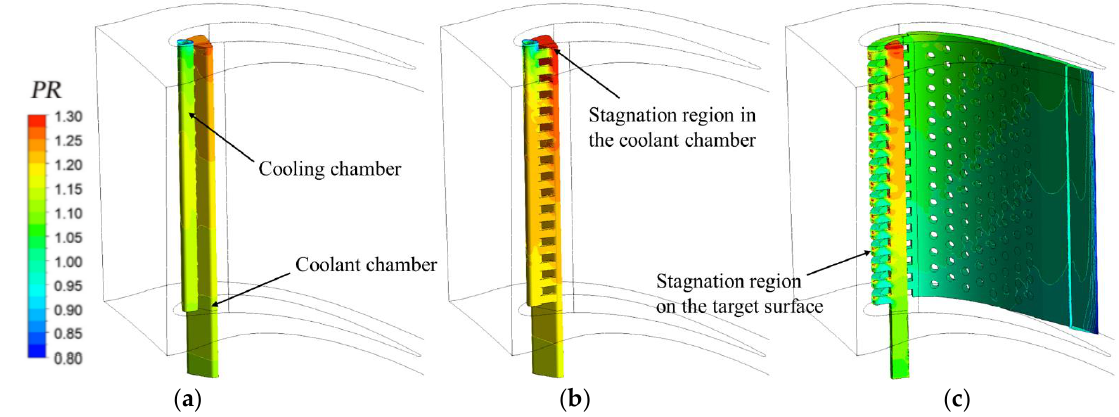
Figure 14. Pressure ratio distribution of different internal cooling structures ( Re j = 20,000); ( a ) Impingement cooling; ( b ) Swirl cooling; ( c ) Wall jet cooling.